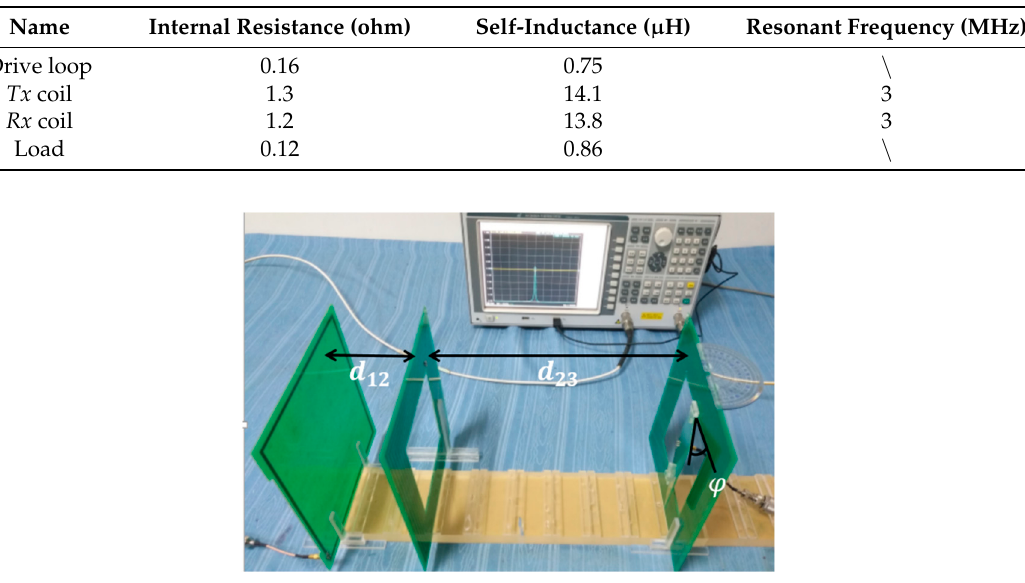
Figure 9. Experimental setup of the four-coil WPT system.